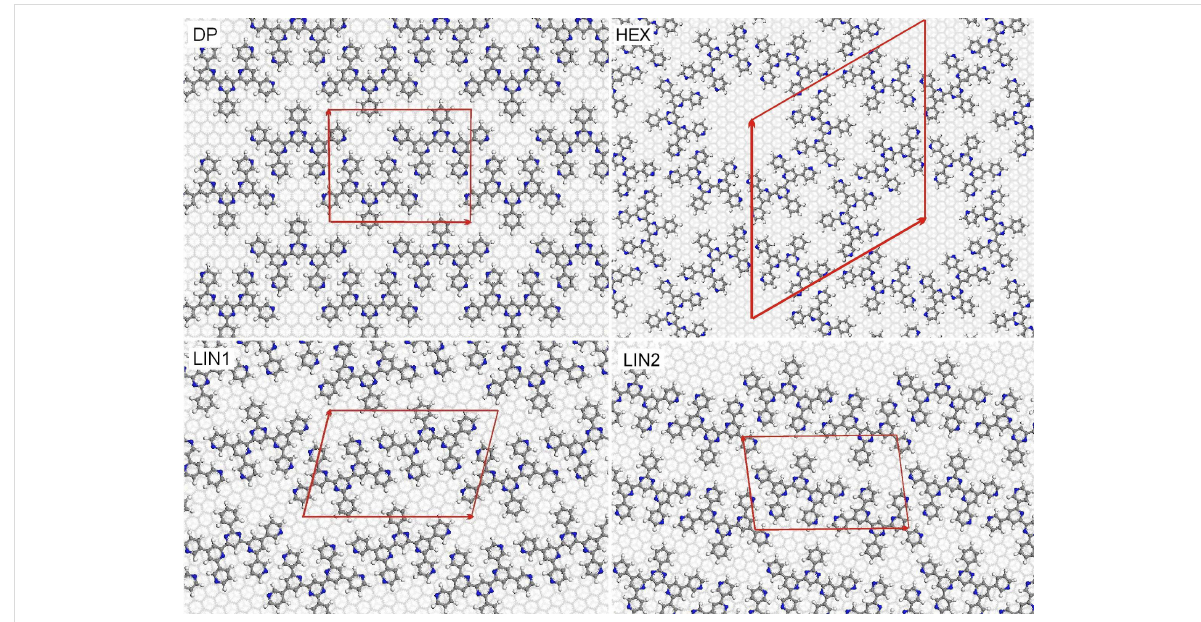
Figure 8: Structural models of the different 3,3 ′ -BTP surface structures that have been observed at the liquid/solid interface.